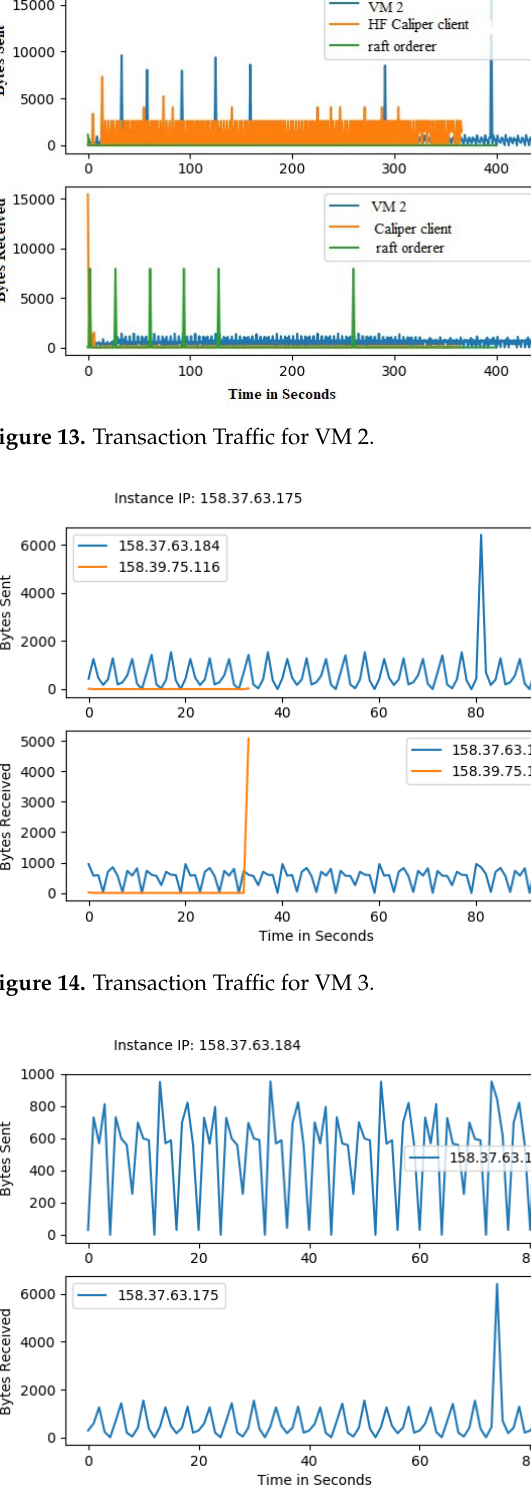
Figure 15. Transaction Traffic for RAFT